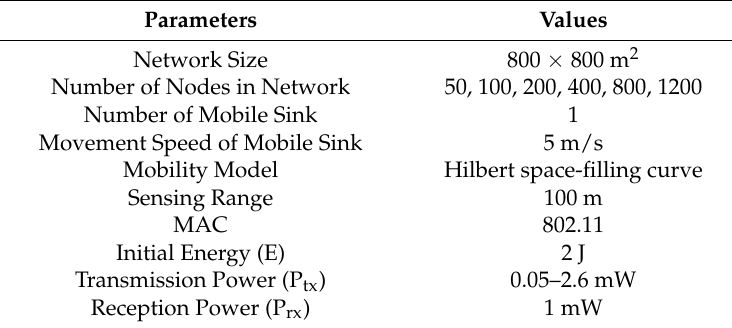
Table 2. Simulation